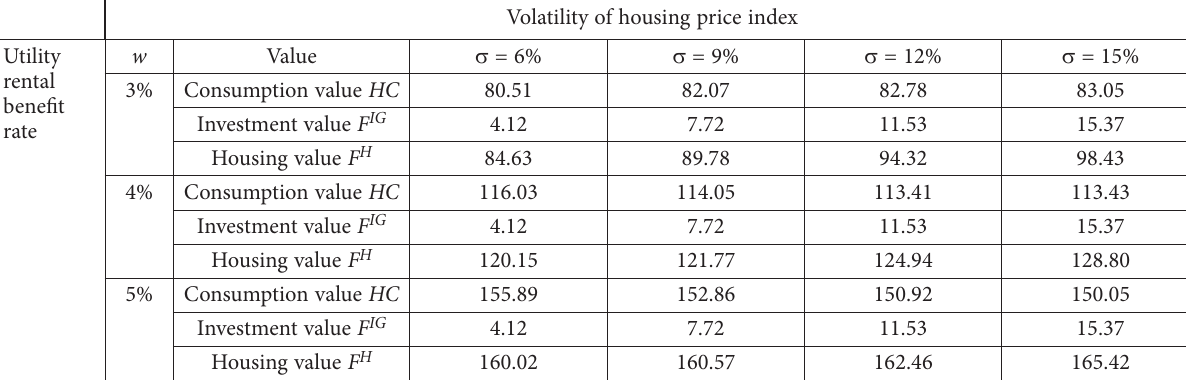
Figure 1. Volatility of housing price index and housing Table 2. Consumption, investment, and housing values across the volatility of housing price index and utility rental benefit rate * Volatility of housing price index